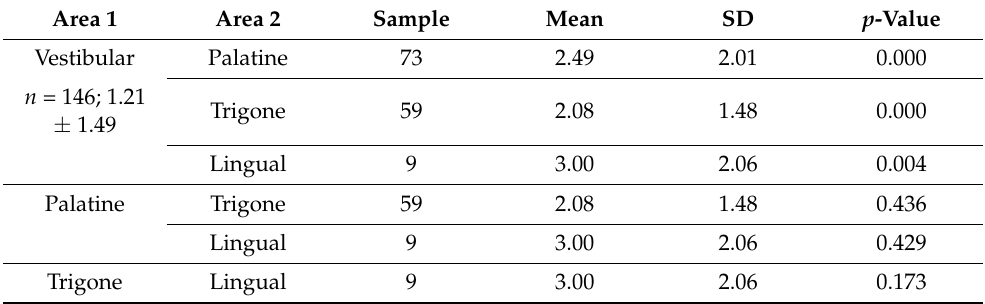
Table 3. VAS comparison and statistical significance based on the area of injection.